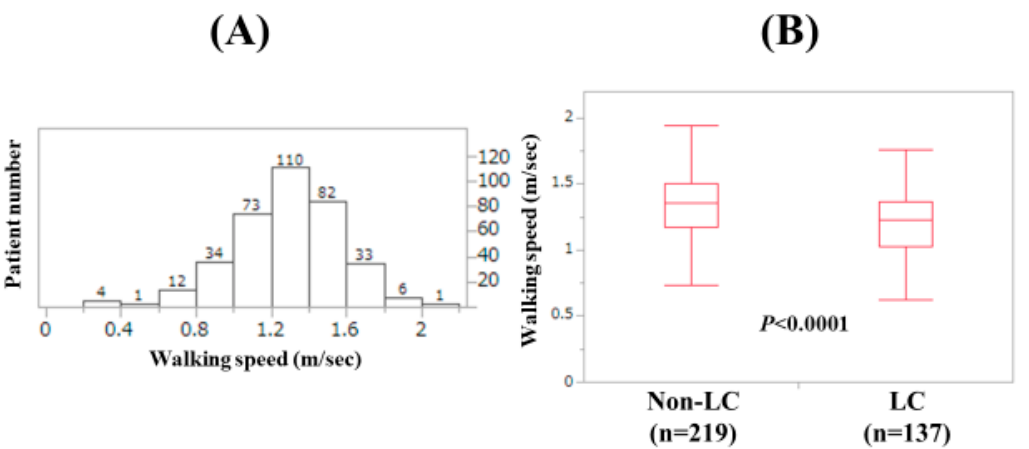
Figure 1. ( A ) Patient number distribution according to walking speed (WS). ( B ) The WS value according to the LC status.